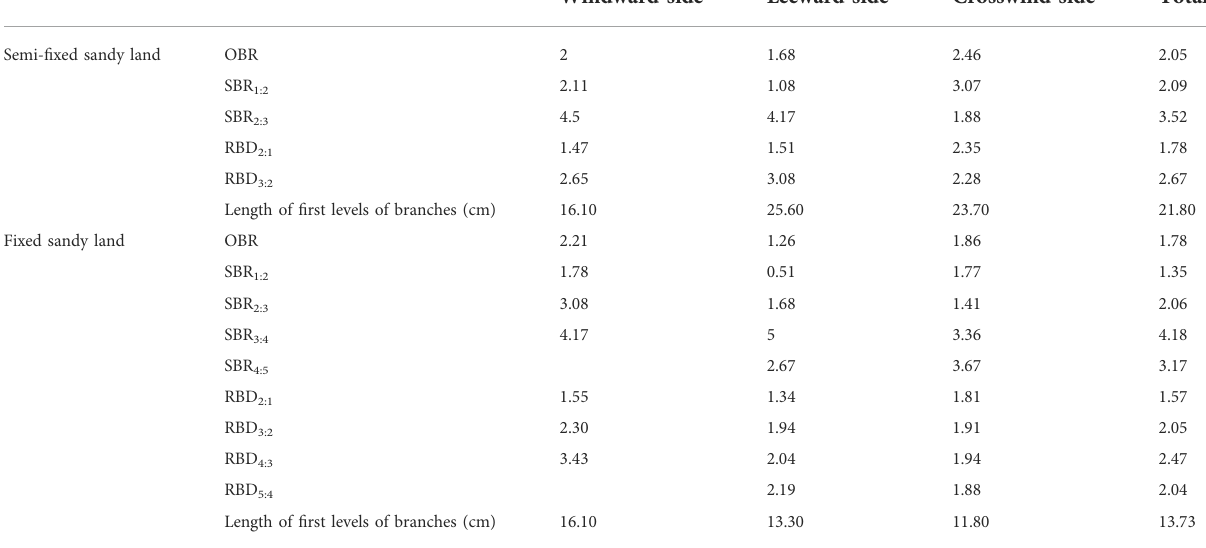
TABLE 2 Analysis of the branching architecture of Artemisia ordosica